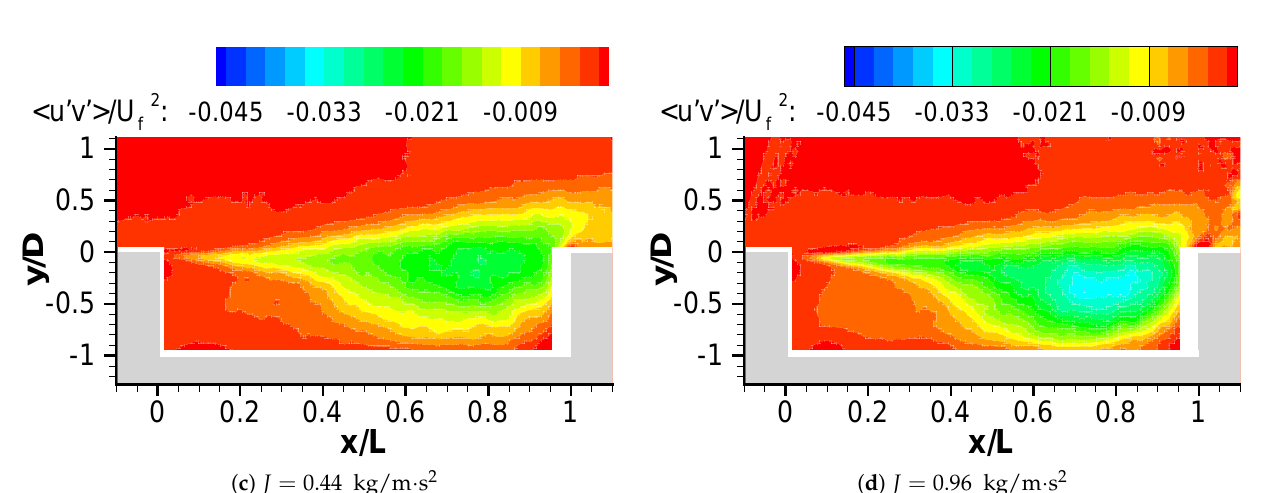
for Re D ≈ 50,000; f